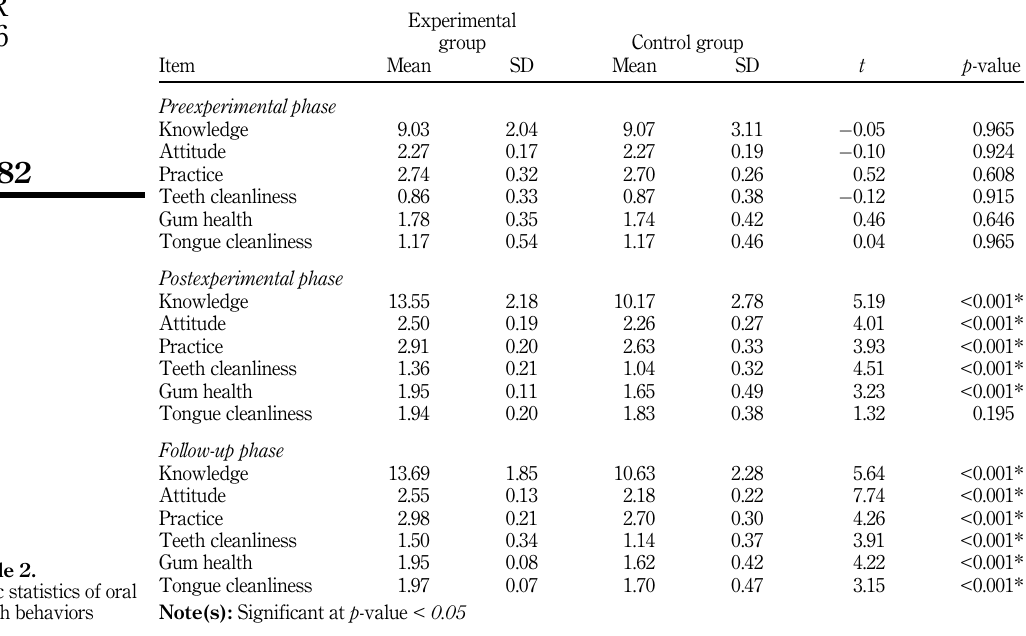
Table 2. Basic statistics of oral health behaviors